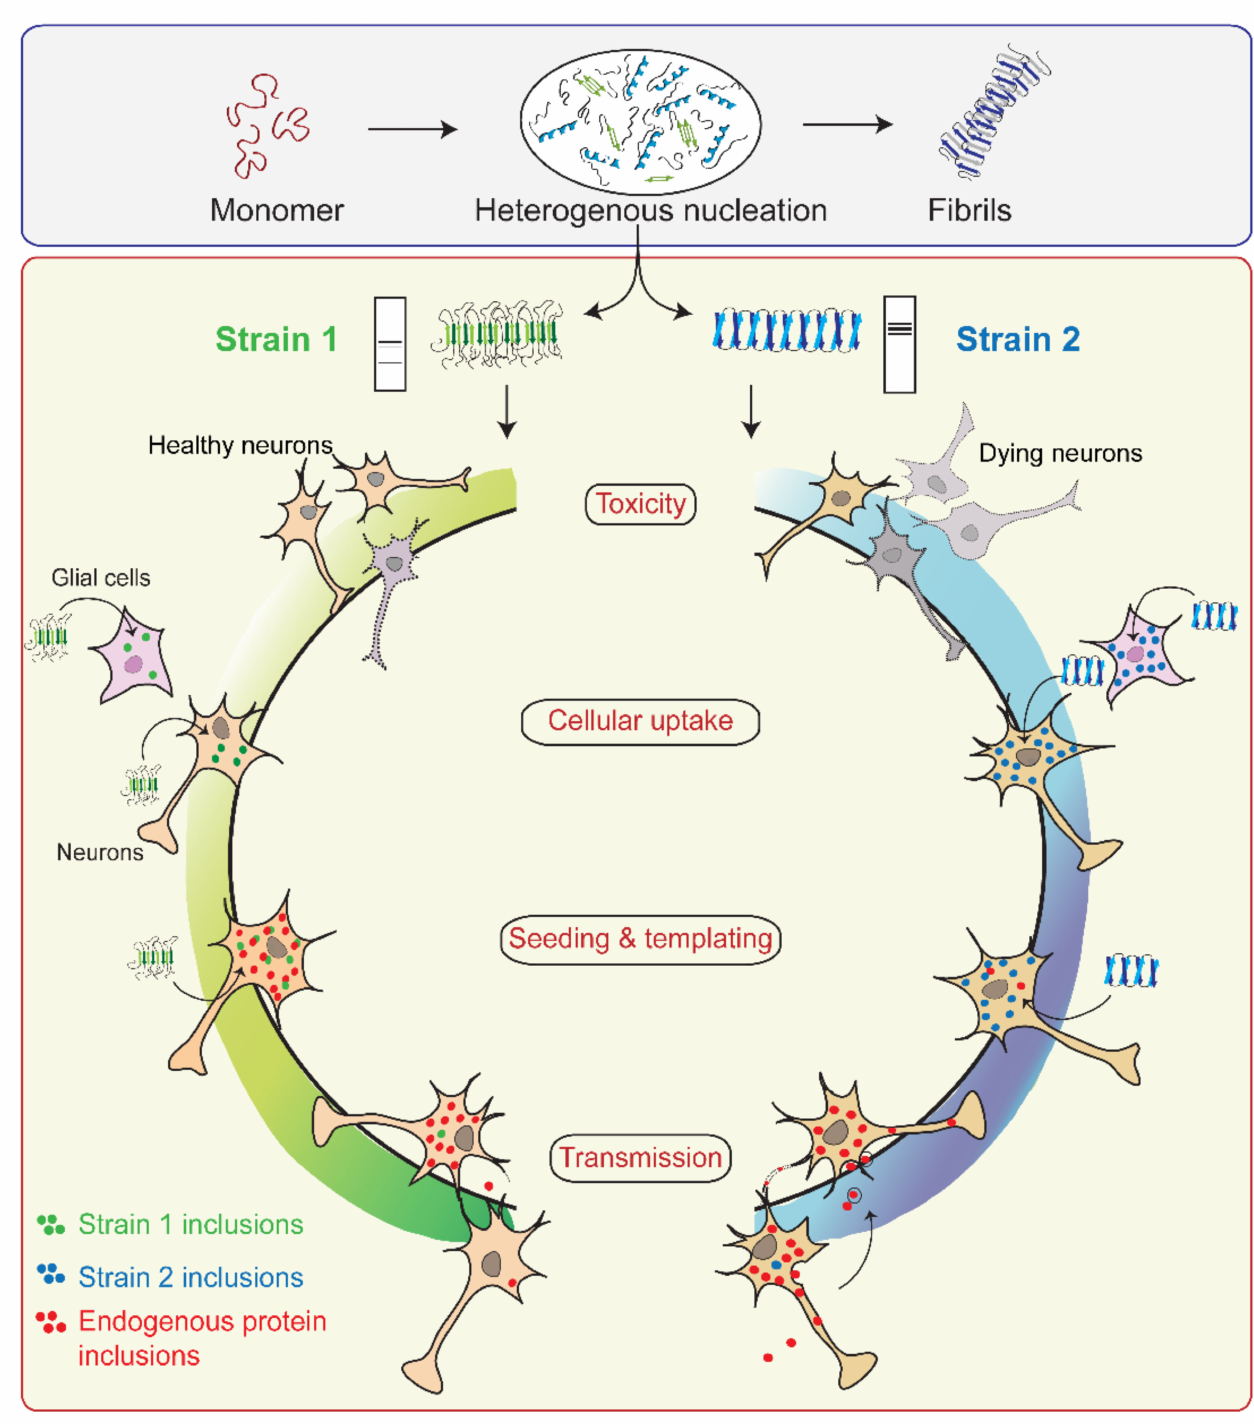
Figure 5. Prion-like behavior of α -Syn strains. Heterogeneous nucleation in the α -Syn aggregation pathway can lead to structurally and functionally distinct strains 1 and 2. These strains can exhibit variable cytotoxicity and prion-like properties of fibrils, which include cellular uptake, seeding, and templating and intracellular transmission of aggregates in cells. ( The figure is reproduced and modified from thesis entitled “Structural and Functional Insights into α -Synuclein Fibril Polymorphism: Implications in Synucleinopathies” by Surabhi Mehra (2020) IIT Bombay